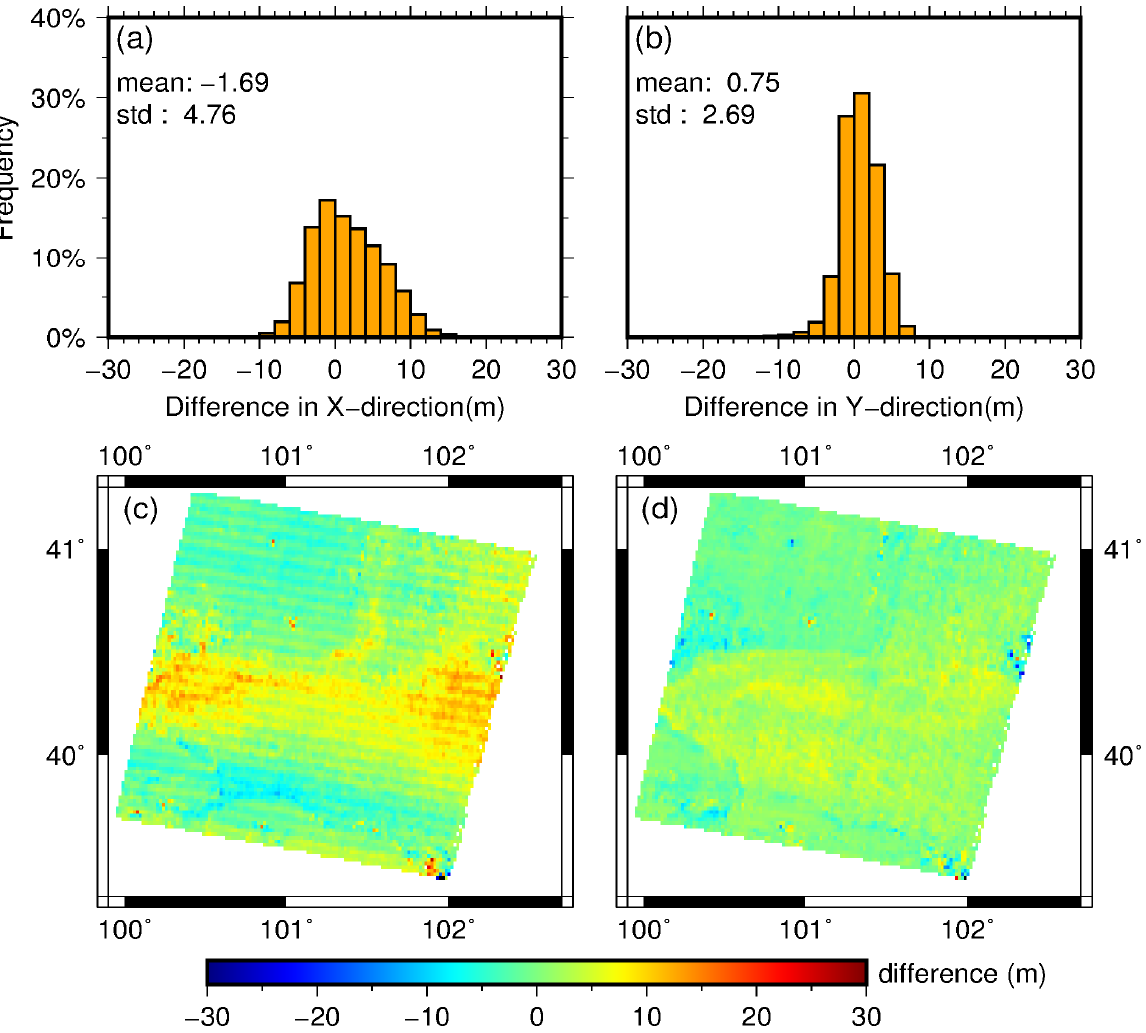
Figure 4. The differences in dune migration between the Landsat 5/8 and 7/8 pairs: ( a , c ) show the differences in the frequency and spatial distribution of the two pairs in the X direction, respectively, while ( b , d ) show the differences in the Y direction.